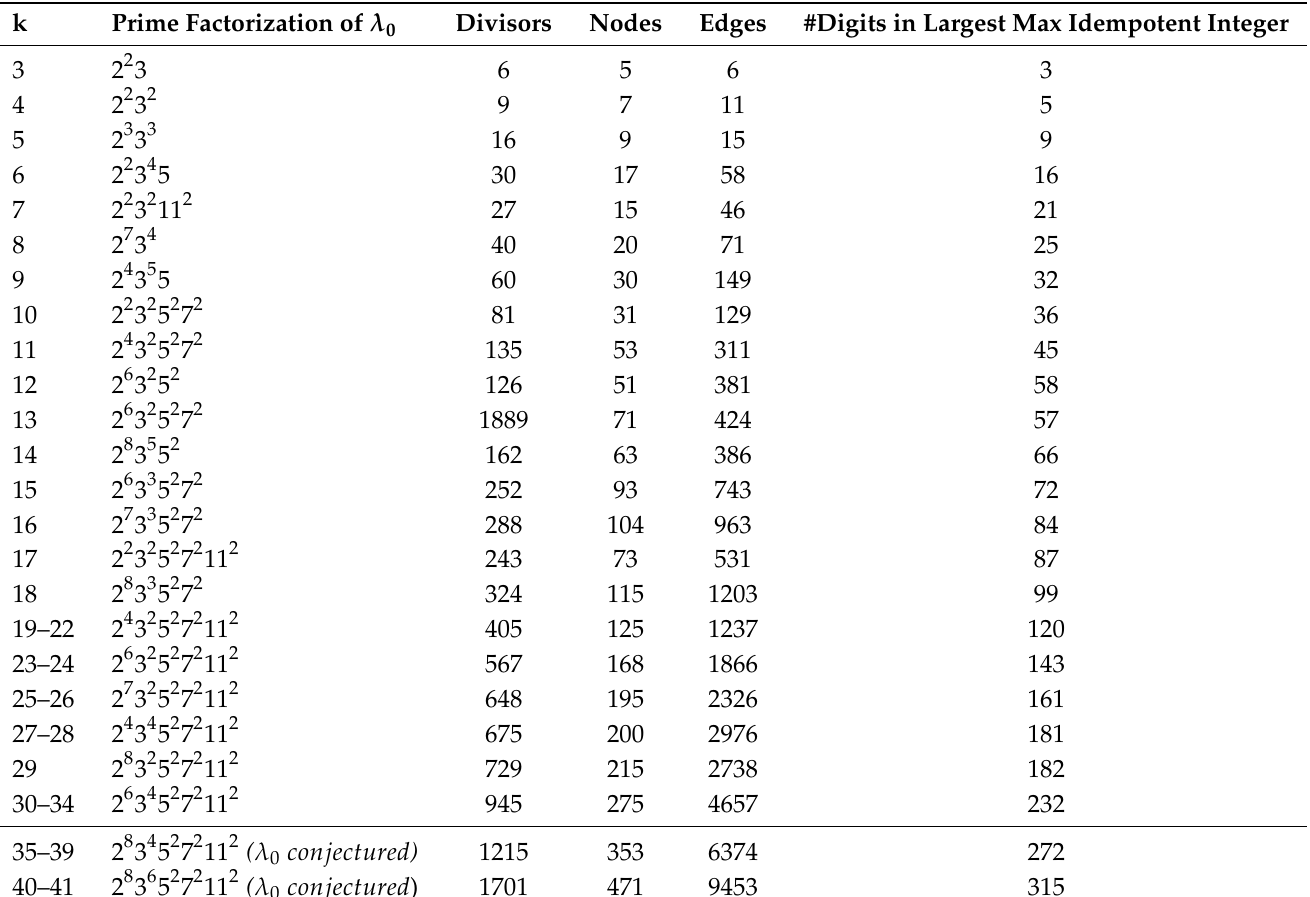
Table 7. Smallest λ 0 where k-cliques first appear in congruence